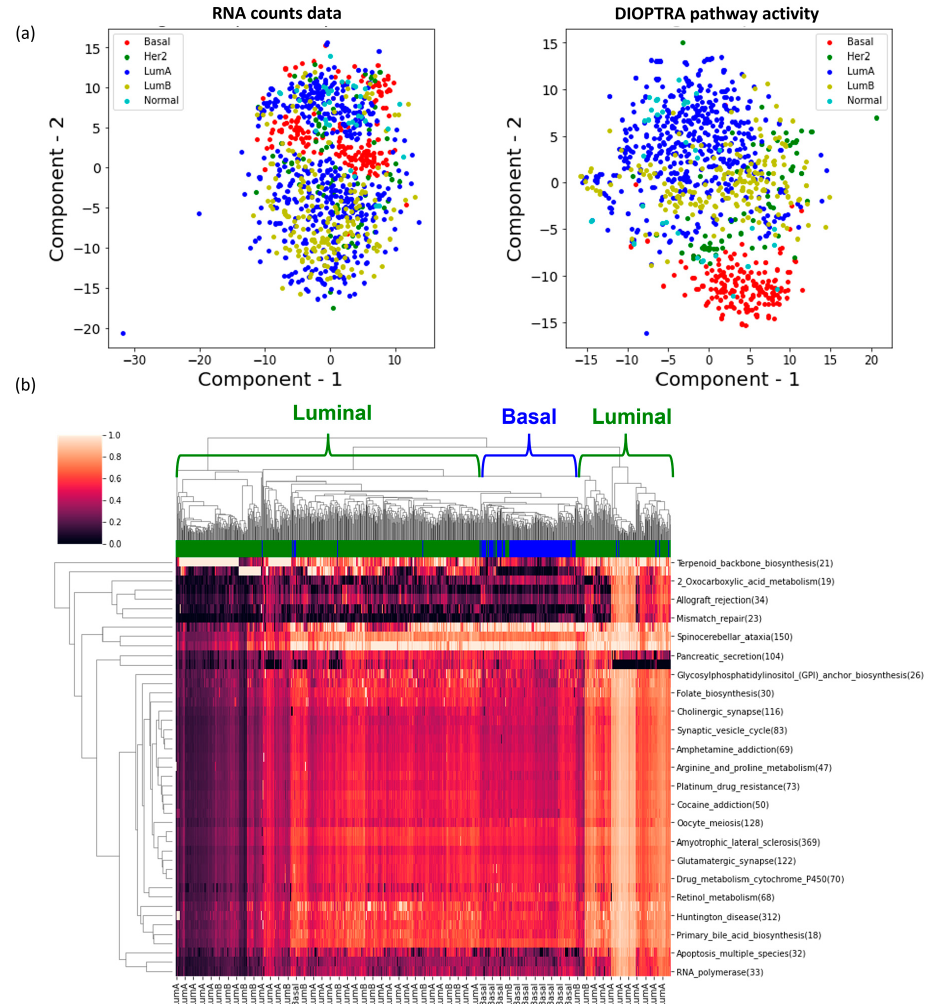
Figure 5. Visualisations of significant pathways in BRCA. ( a ) The left tSNE plot is generated from the RNA count data with genes across all KEGG pathways, while the right scatter plot is generated from the activities for KEGG pathways derived from the DIOPTRA model using all samples. ( b ) The hierarchical clustering heatmap represents pathway activities of the top 70 pathways with the highest prediction accuracy in